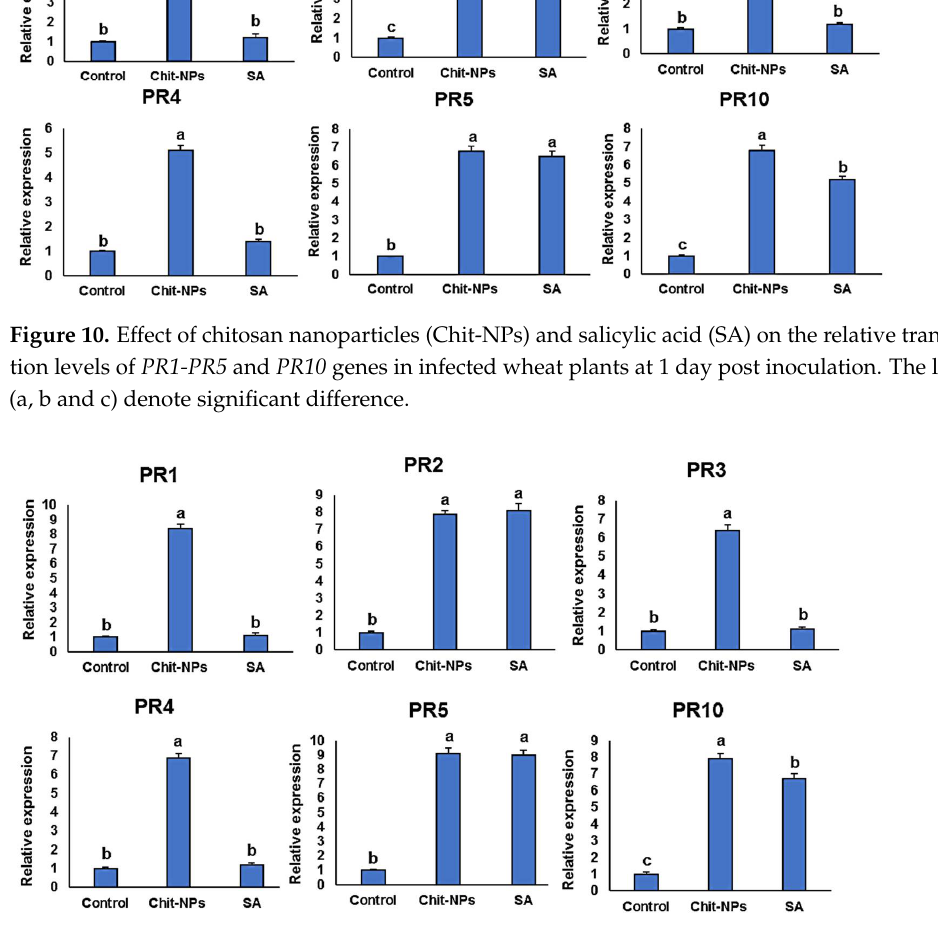
Figure 11. Effect of chitosan nanoparticles (Chit-NPs) and salicylic acid (SA) on the relative transcription levels of PR1-PR5 and PR10 genes in infected wheat plants at 2 days post inoculation. The letters (a, b and c) denote significant difference.